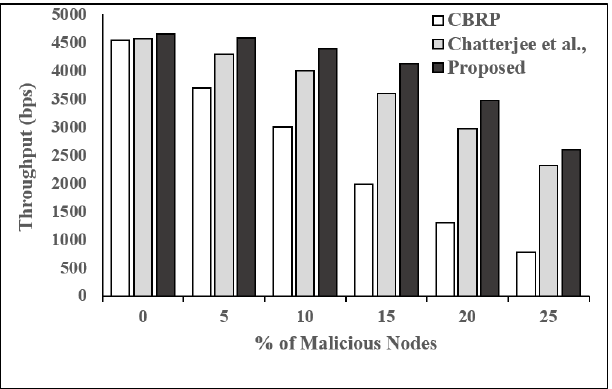
Figure 8. Throughput vs. number of malicious